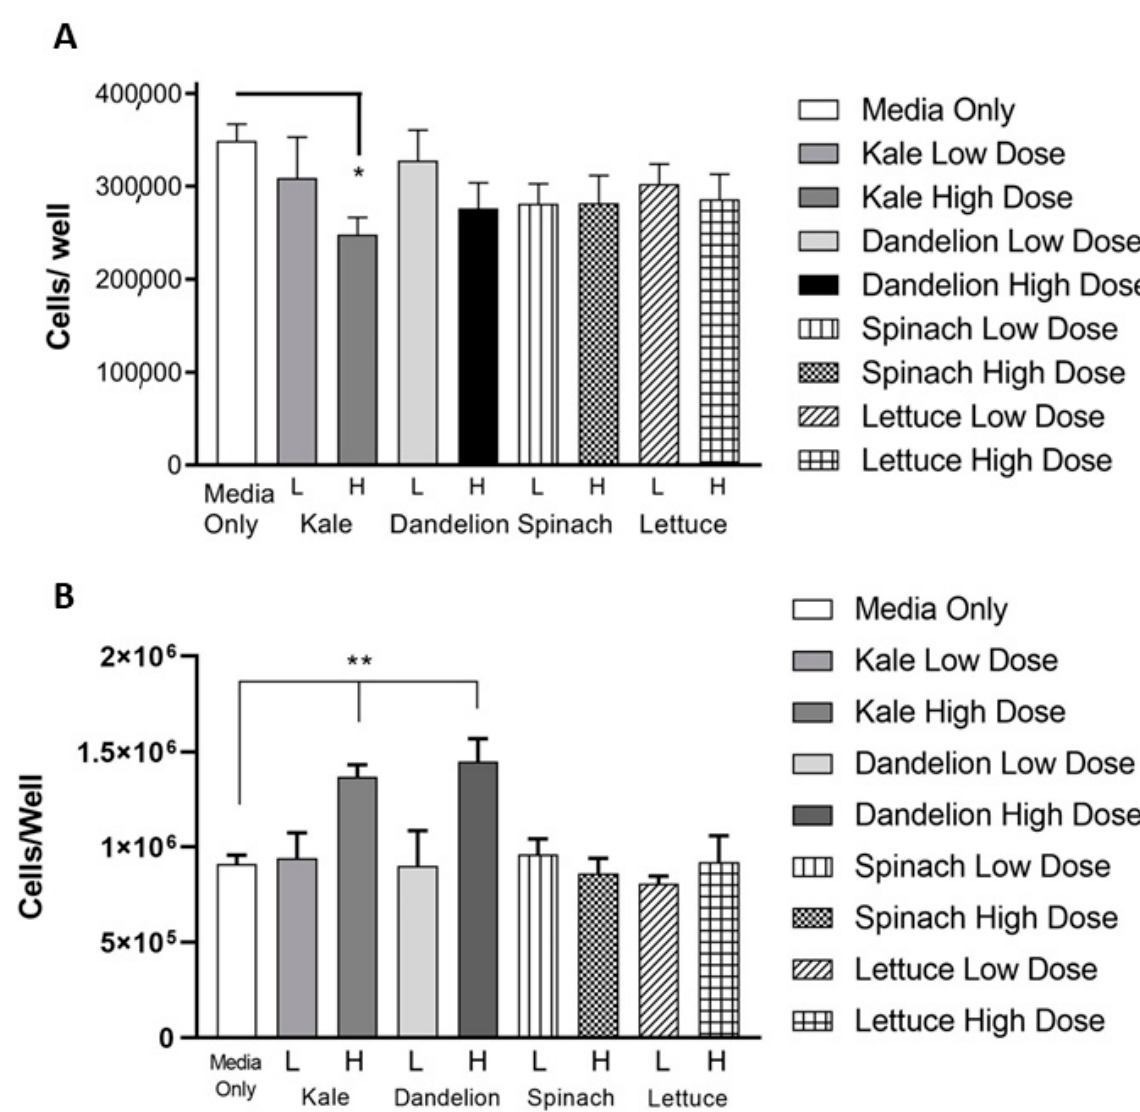
Figure 2. Effects of apical vegetable juices on cell counts by cellometry as per Scheme 2 and Figure 1, harvested after 3 days in co-cultures. The upper panel ( A ) shows SH-SY5Y total cell numbers taken by pooling attached and floaters from the co-culture well bottoms. The lower panel ( B ) shows epithelial carcinoma, Caco-2Bbe1 , total cell numbers taken by pooling attached and floaters from the co-culture inserts. The graph shows total cells whether trypan blue excluded or not, however the average percent viabilities values (trypan blue excluding) were as follows: from phosphate-buffered saline-high apically, 74.4% viability; SH-SY5Y from kale-low apically, 79.4% viability; SH-SY5Y from kale-high apically, 81.4% viability; SH-SY5Y from dandelion-low apically, 82.4% viability; SH-SY5Y from dandelion-high apically, 79.3% viability; SH-SY5Y from spinach-low apically, 63.0% viability; SH-SY5Y from spinach-high apically, 69.7% viability; SH-SY5Y from lettuce-low apically, 78.3% viability; SH-SY5Y from lettuce-high apically, 69.6% viability; Caco-2Bbe1 from phosphate-buffered saline- high apically, 72.7% viability; Caco-2Bbe1 from kale-low apically, 73.2% viability; Caco-2Bbe1 from kale-high apically, 75.1% viability; Caco-2Bbe1 from dandelion-low apically, 74.0% viability; Caco-2Bbe1 from dandelion-high apically, 74.6% viability; Caco-2Bbe1 from spinach-low apically, 72.5% viability; Caco-2Bbe1 from spinach-high apically, 50.8% viability*; Caco-2Bbe1 from lettuce-low apically, 71.3% viability; Caco-2Bbe1 from lettuce-high apically, 74.5% viability. Asterisks mark the statistical group differences from appropriate phosphate-buffered saline controls. Graph bars represent the mean ± SEM ( n = 4–5 experiments per condition). Details comparing the low (0.7%) and high (4.2%) doses to what human’s drink are discussed in the methods section. * p < 0.05, ** p < 0.01, compared to media-only by two-tailed